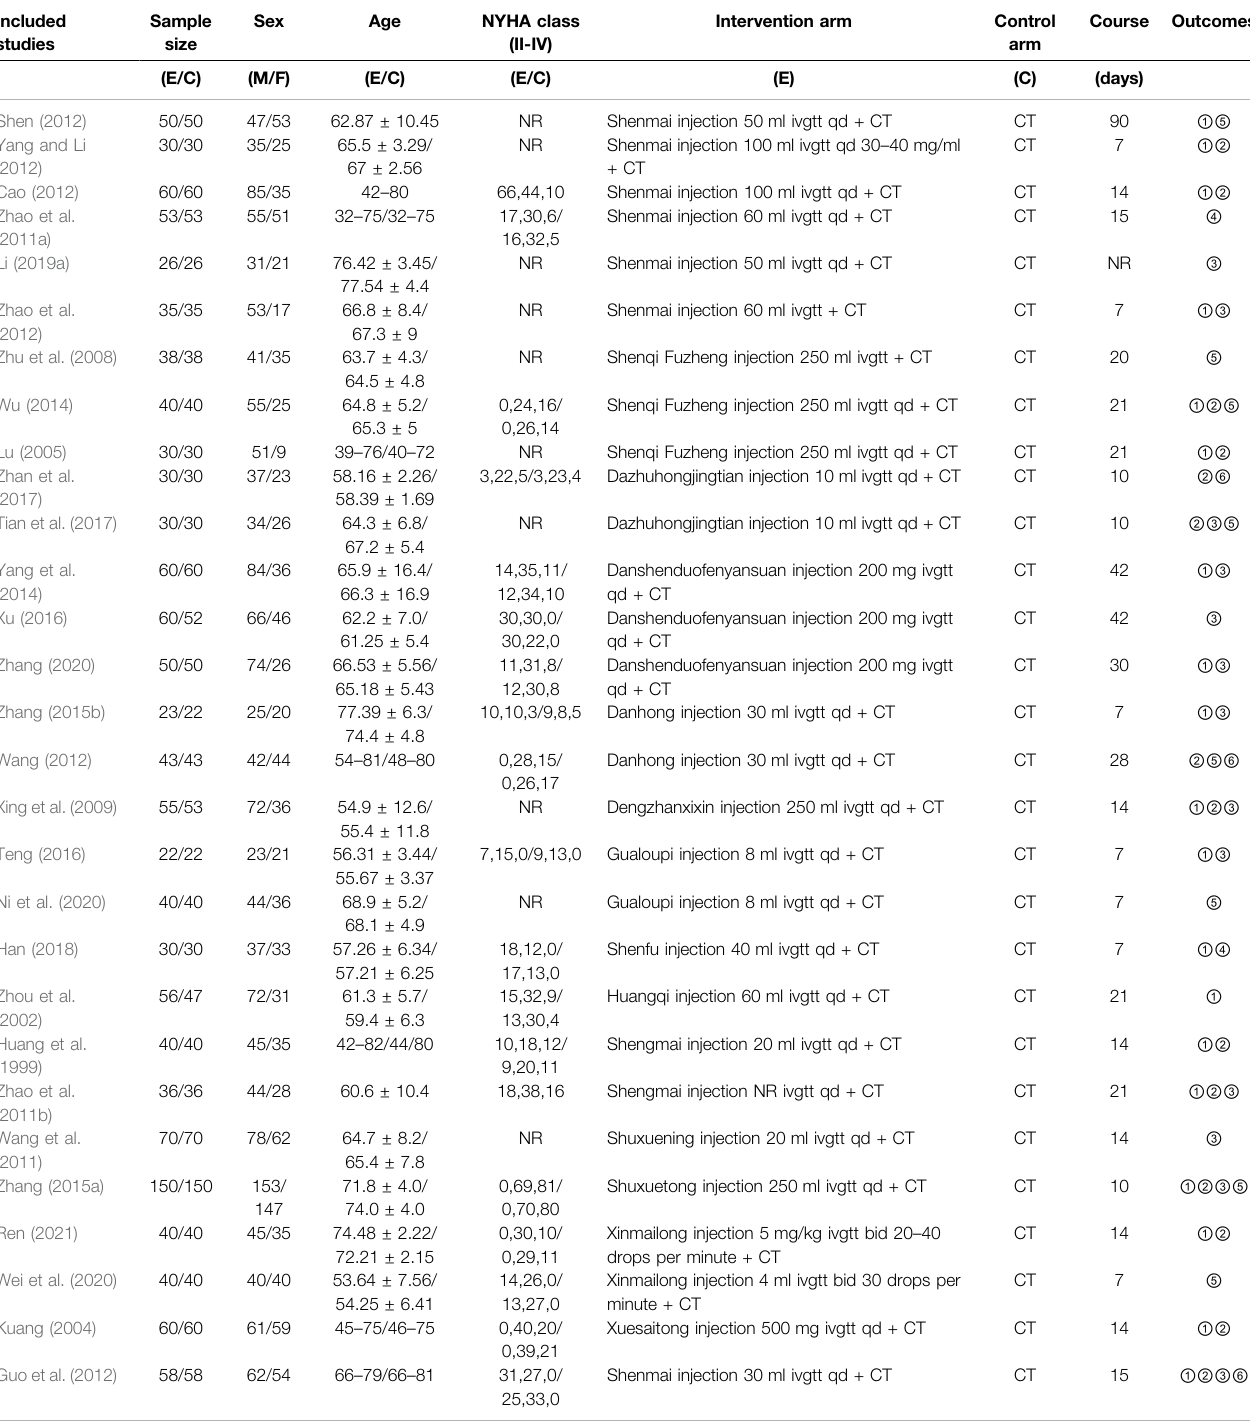
TABLE 1 | ( Continued ) Baseline characteristics of studies included in the network